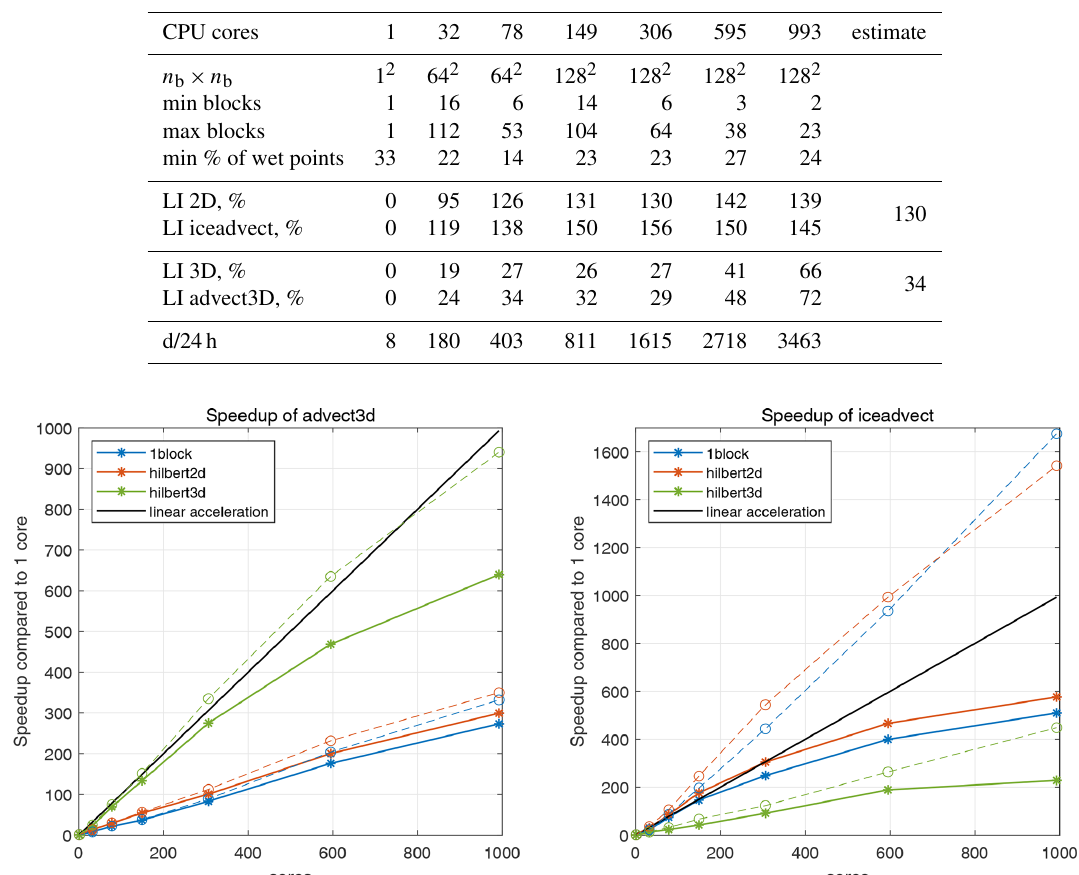
Figure 4. Speedup compared to one core for two functions: advect3D and iceadvect . Solid and dashed lines correspond to measure- ments with and without MPI exchanges, respectively. Different partitions are shown in color (1block, hilbert2d, and